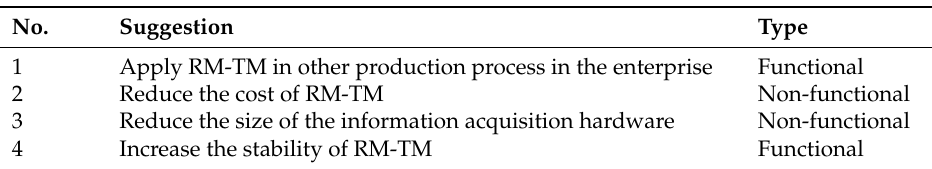
Table 5. Suggestions for